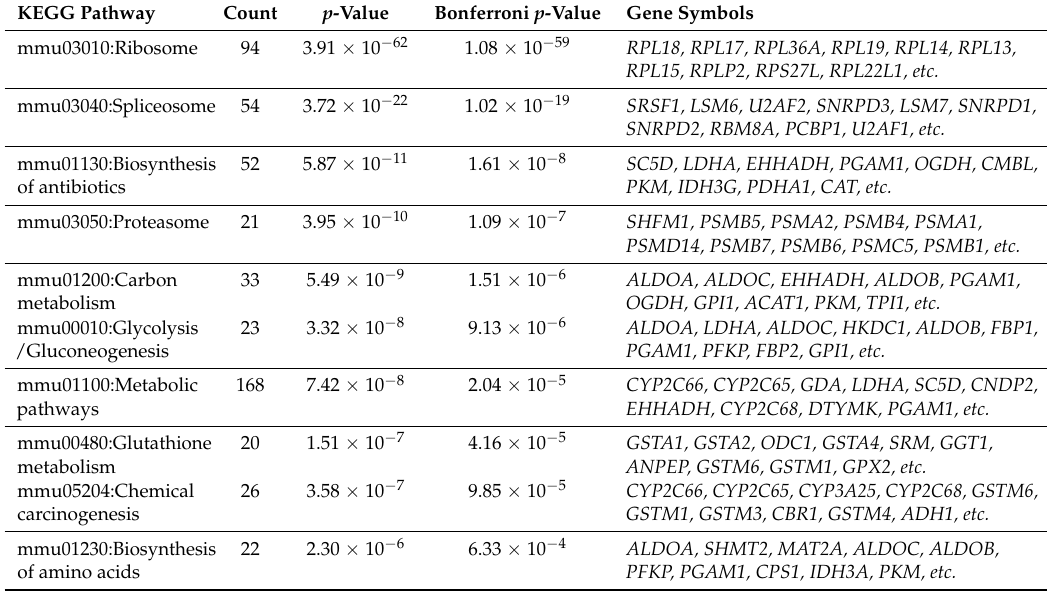
Table 4. Top ten KEGG pathways enriched with the differentially expressed genes.